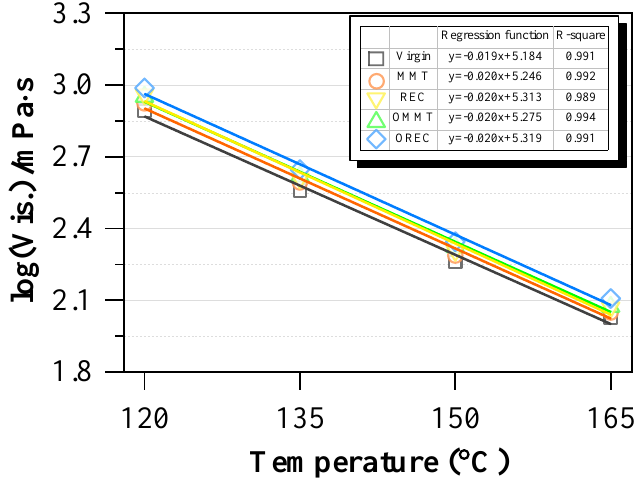
Figure 4. The viscosity result for the bitumen samples at various temperatures.